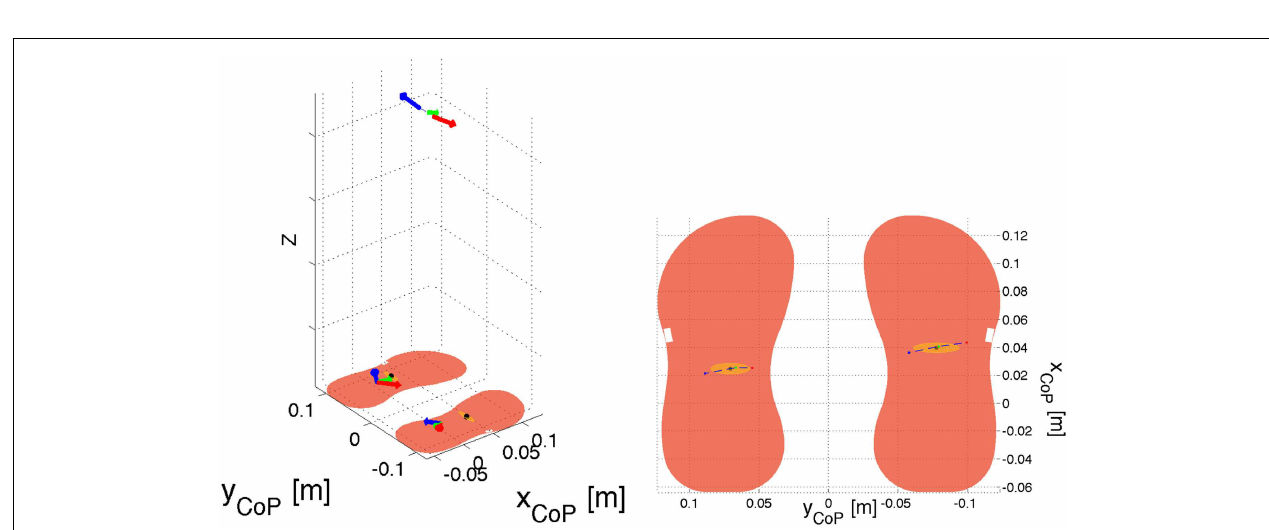
FIGURE 7 | Results of the double-support experiment on planar contacts (left and right feet) .The picture shows the time behavior of forces (top) and center of mass position (bottom) on the sagittal (blue) and transverse (green) axis. It is worth noting that forces should be proportional to center of mass